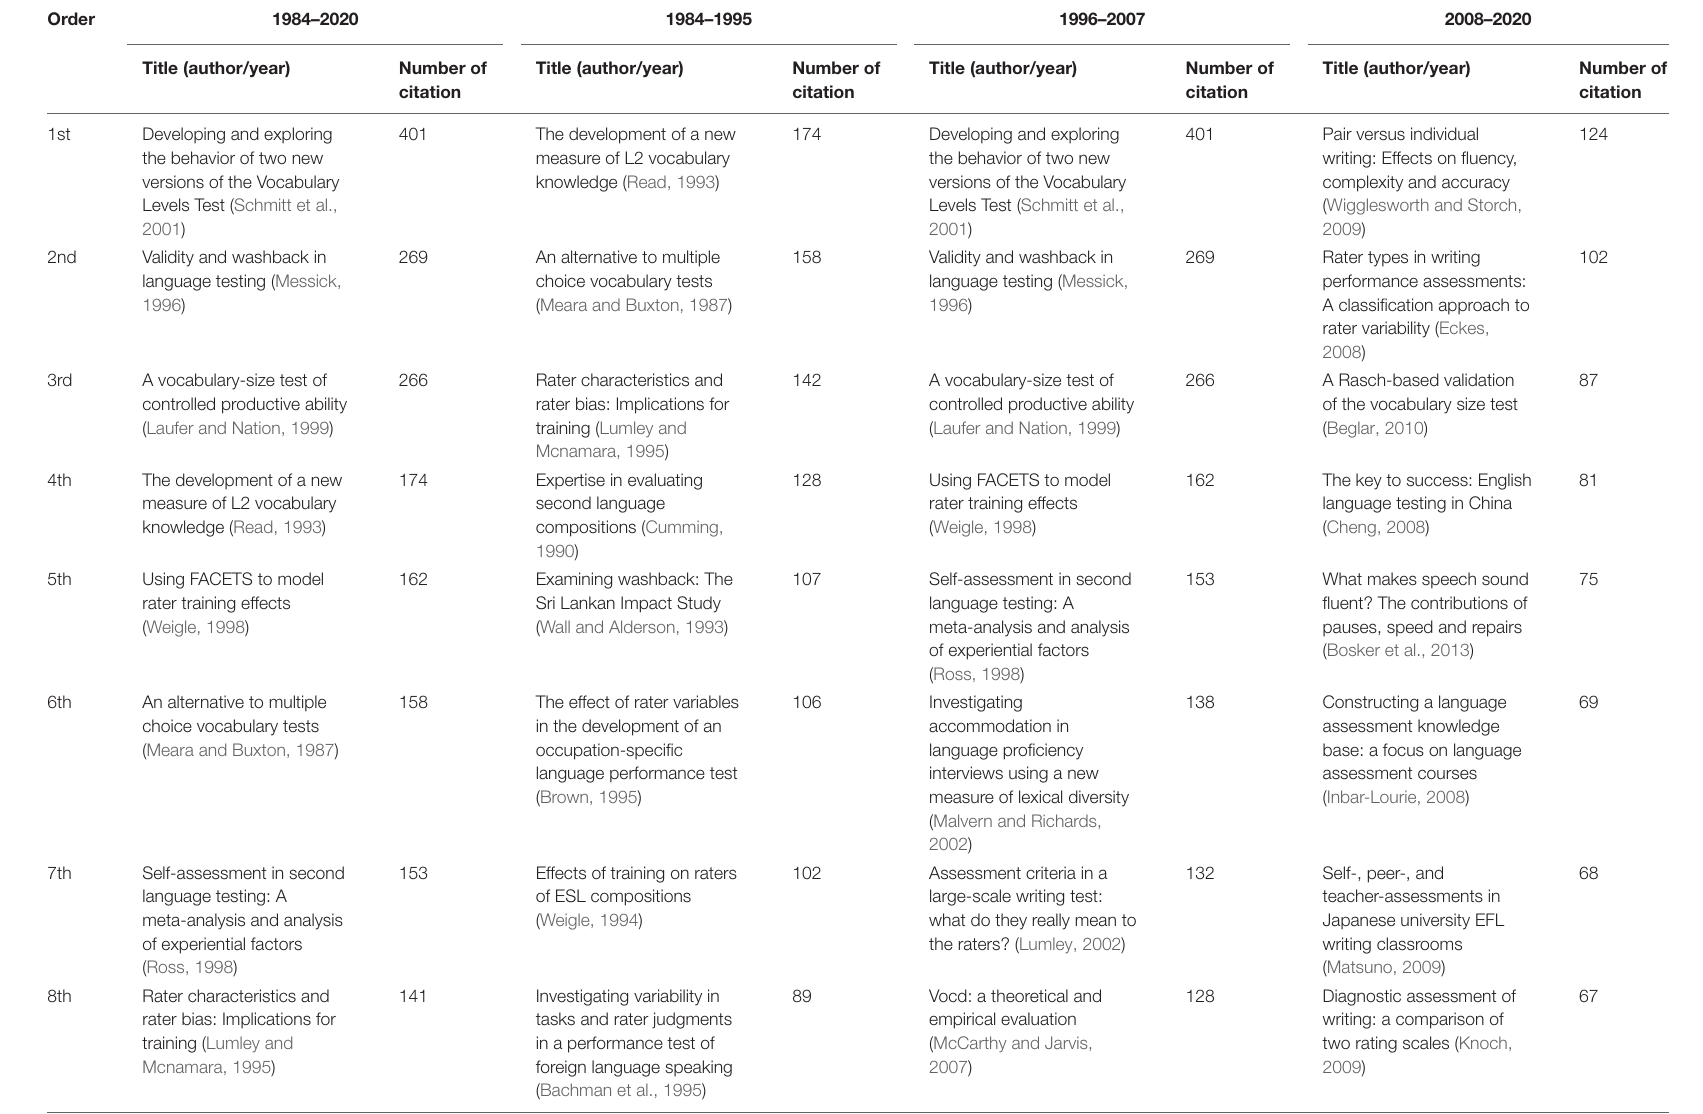
TABLE 4 | Top 10 most highly cited publications.